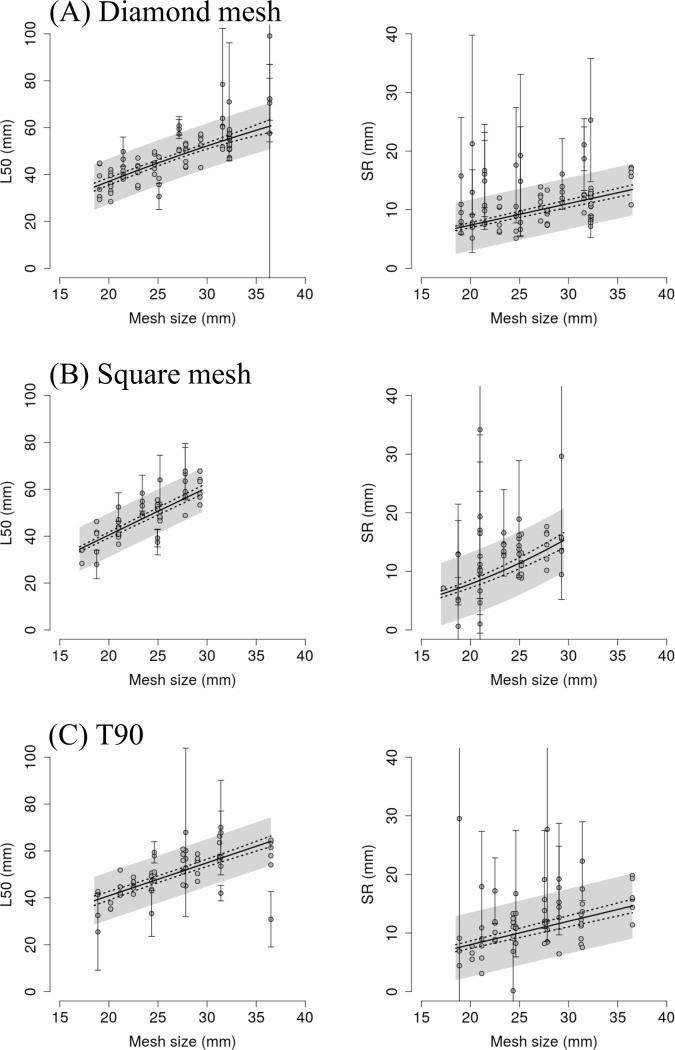
L50 and SR mean values (solid line) estimated by the predictive models for the three different codend mesh types ((A) Diamond mesh, (B) Square mesh, and (C) T90). Predictions are plotted against the L50 and SR values obtained from individual hauls (circle marks). Dotted lines represent the CIs accounting for the uncertainty of the estimation, while the grey band represents the CIs accounting for the total variation in the data, including the between-haul variation. CIs associated to experimental values (vertical lines) only plotted for the experimental points falling outside the grey band. SR predictions for the square-mesh codends and L50 predictions for T90 codends were estimated using a fixed total catch weight of 35 kg, a value near the mean total catches observed in the test codends.